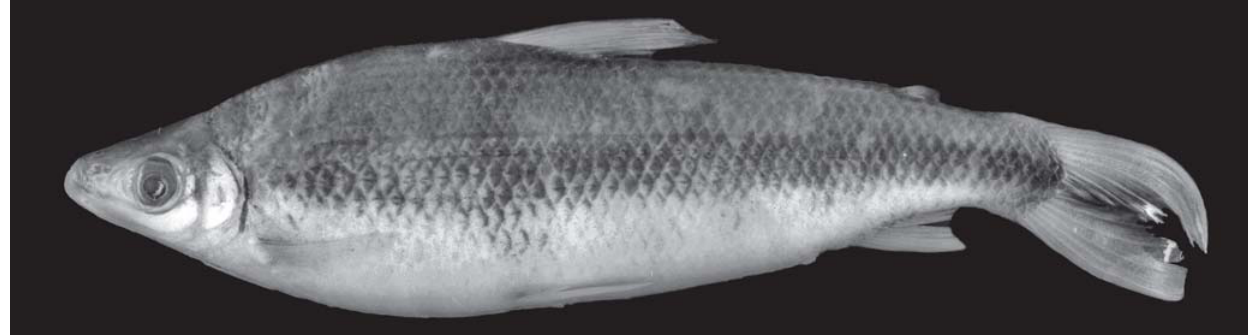
Fig. 6. Adult specimen of Laemolyta fernandezi , INPA 16178, 173.4 mm SL; Brazil, Pará, Base I Tucuruí